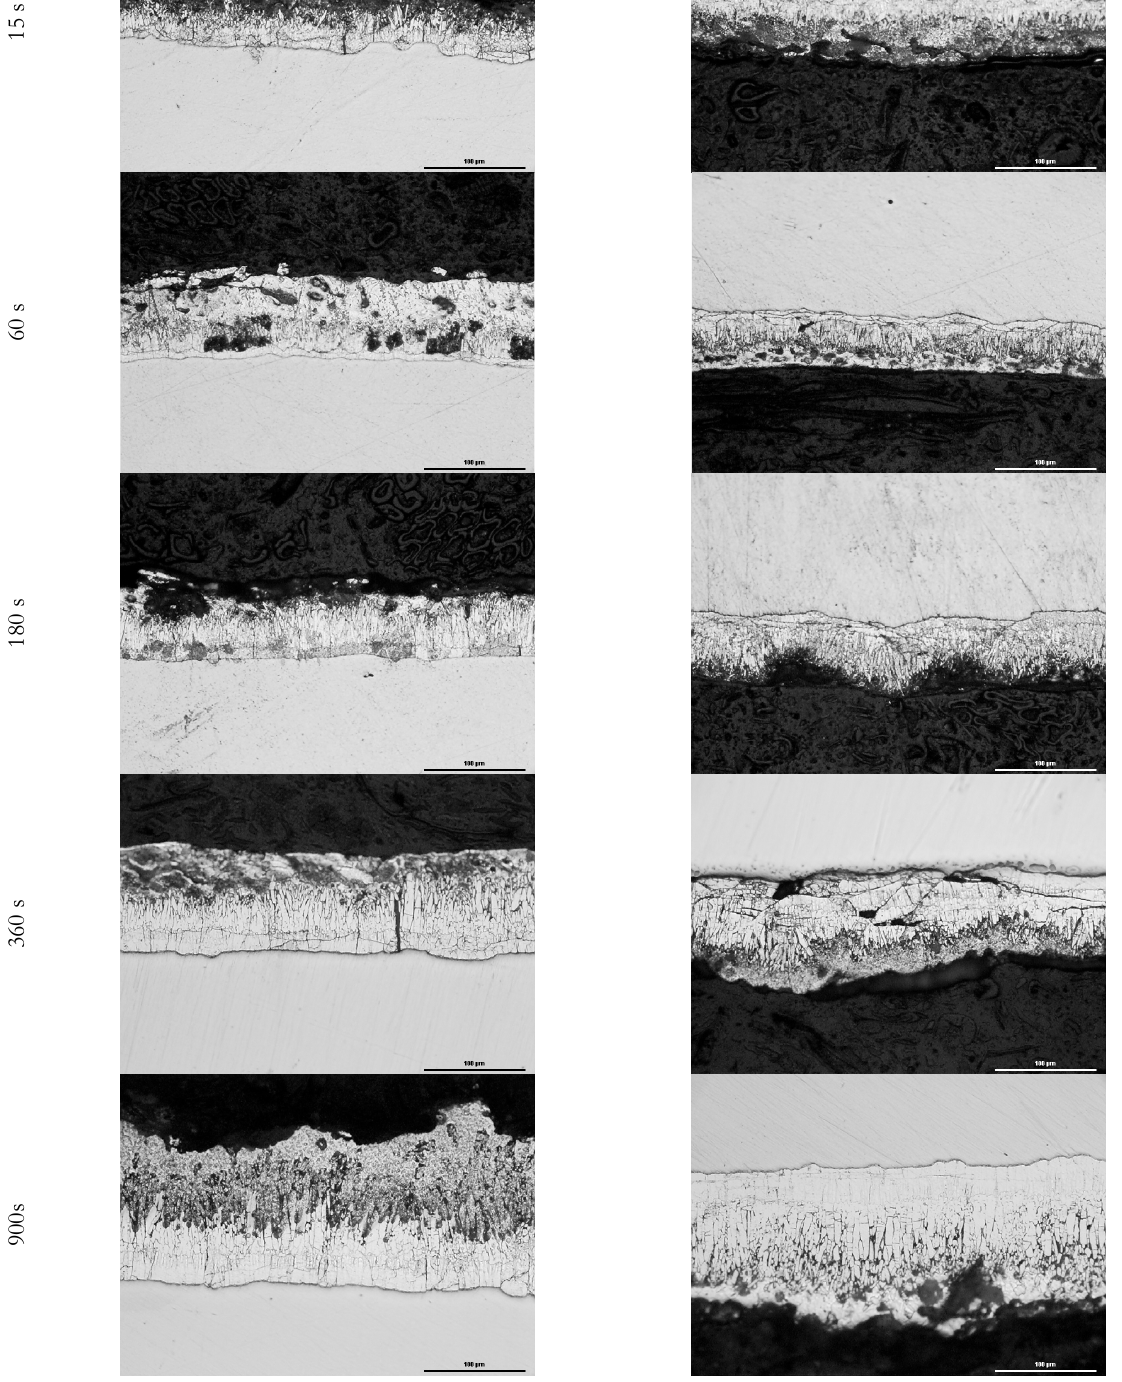
Figure 5: LOM analysis of intermetallic phases damage in Zn-Sn